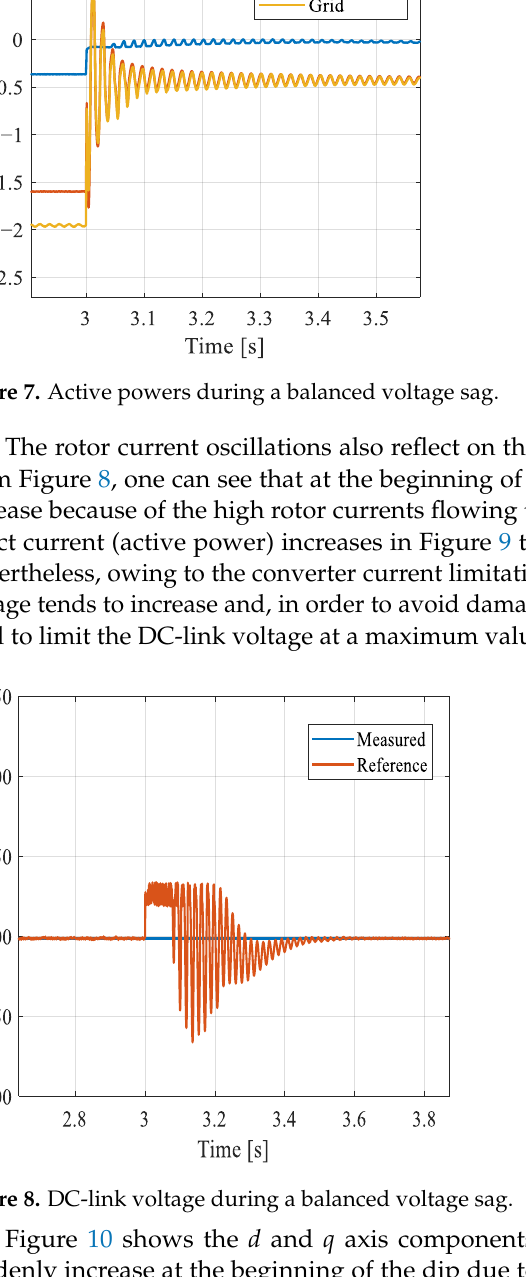
( b ) Figure 6. Currents during a balanced voltage sag: ( a ) stator currents and ( b ) rotor currents.